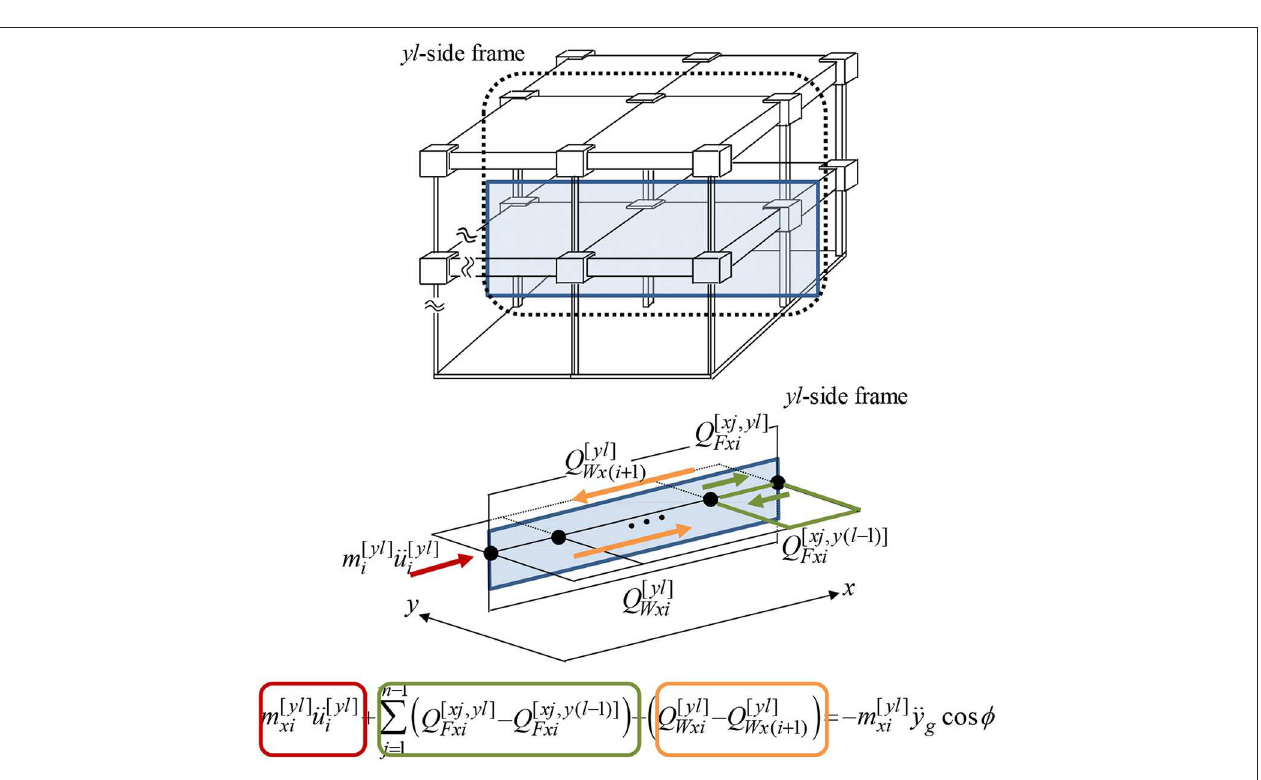
FIGURE 2 | Dynamic equilibrium including story shear force in vertical frame and in-plane force in horizontal frame